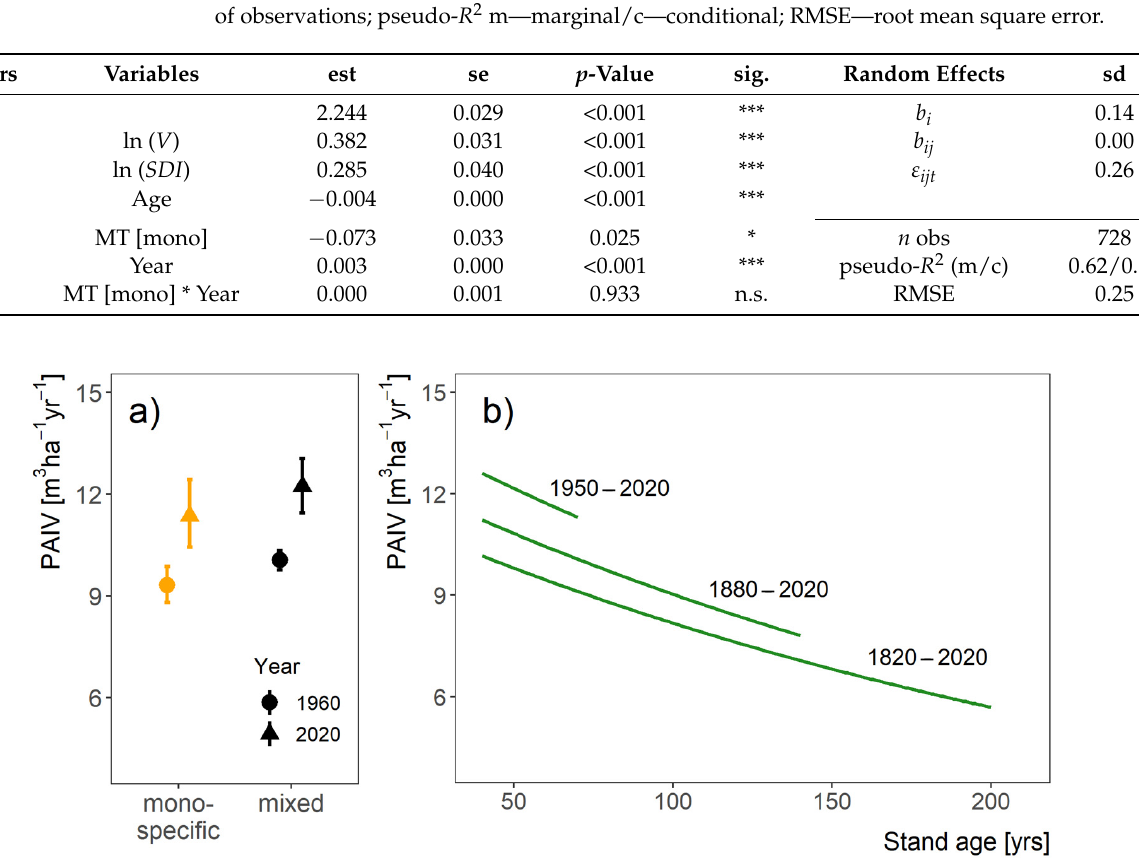
Table 4. Results of the linear mixed effects model on long-term stand productivity (Equation (8));